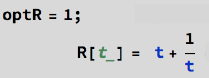
Figure 12. Part of the structure of the [SInt] algorithm corresponding to Option 1 to input r